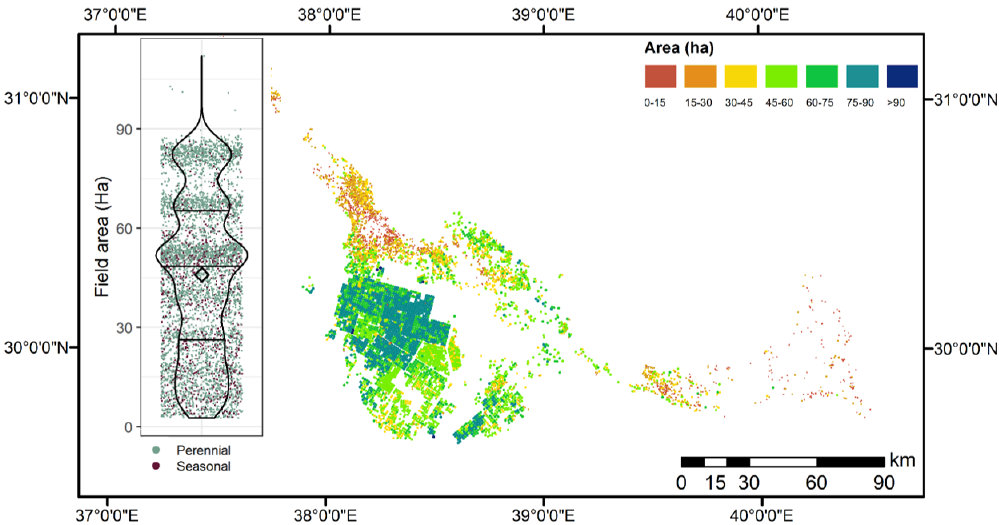
Figure 7. Spatial distribution and statistics of individual field areas. Clusters of large fields (those > 60ha) can be found in the main agri- cultural zone (30 ◦ N, 38.25 ◦ E), corresponding to the location of several large commercial-scale farms. The figure’s inset on the left shows a violin plot of the field sizes in Al Jawf: in a given field area ( y axis), the plot outline (in black) is wider when there is a larger number of fields of that given size. The black horizontal lines inside the plot show the first quartile, median, and third quartile, while the black diamond shows the average value. The background in the inset shows colored dots (horizontal positions are given randomly for visualization purposes) to distinguish perennial and seasonal fields.